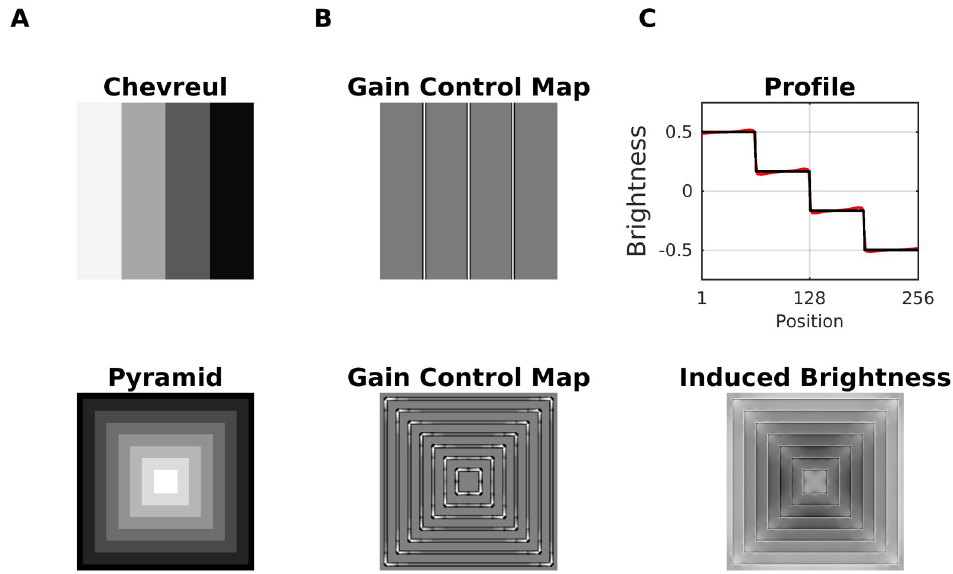
Fig 19. Model predictions for luminance staircase and pyramid (Chevreul’s illusion). (A) Top: Luminance staircase. Bottom: luminance pyramid. (B) The corresponding gain control maps as a result of dynamic filtering. (C) Top: Profile plot of the estimated brightness (red line) of the luminance staircase (black line). Bottom: The induced brightness, which consists of the difference map between estimated brightness and input luminance (i.e., brighter gray level mean positive values, and darker gray levels mean negative